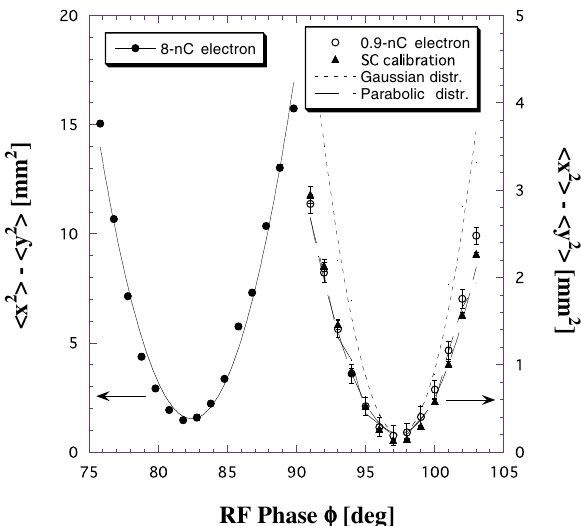
FIG. 6. (Color) Variations of the quadrupole moment for the 0.9 and the 8-nC electron beams depending on the rf phase of the booster klystron. The solid line for the 8-nC electron beam shows a curve with a quadric least-squares fitting procedure. The other curves for the 0.9-nC electron beam show curves with a quadric least-squares fitting procedure assuming the transverse-distribution functions [see the text (Sec. VI A) for details].